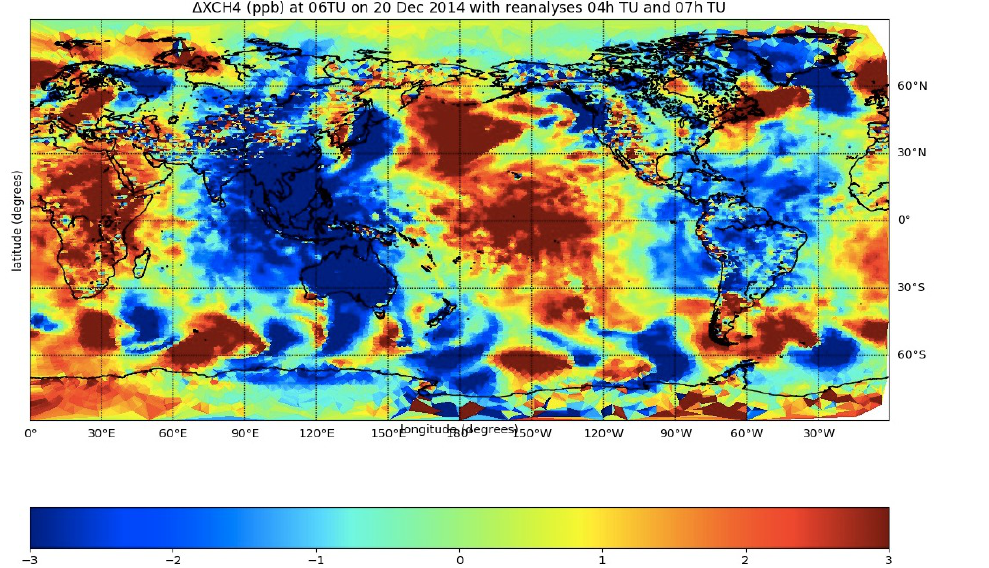
Figure 5. Figure, made by Edouard Martins and Jordi Chinaud and reproduced with their kind permission, showing the difference at 06H UT for 20 December 2014 between the amount of methane obtained with the meteorological fields reanalysed at that time and that obtained with an interpolation between the meteorological fields reanalysed at 04H UT and 07H